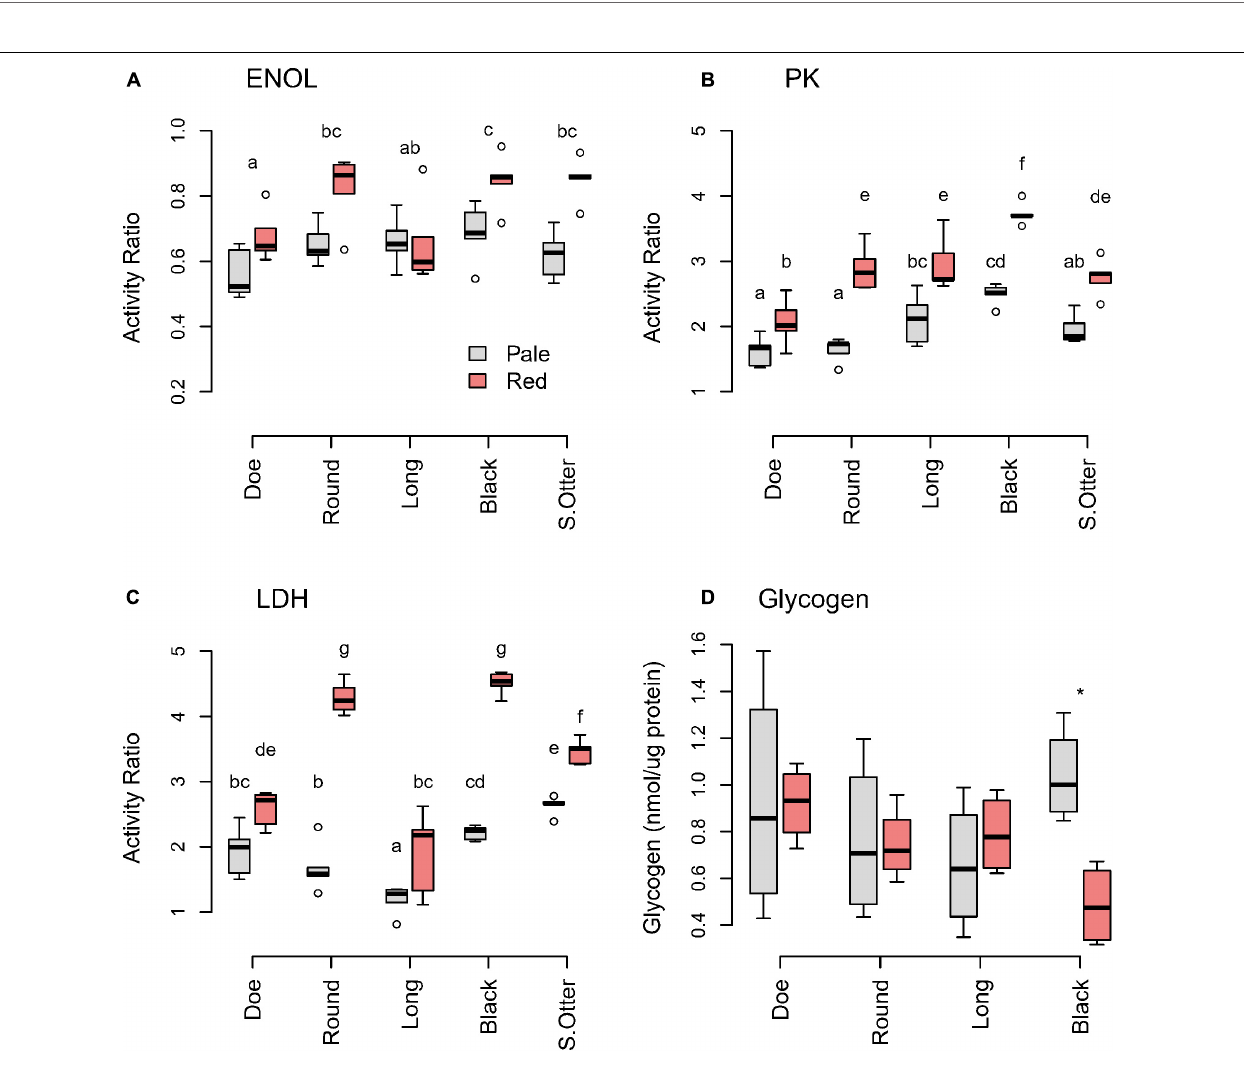
FIGURE 3 | Glycolytic enzyme ( A: ENOL; B: PK; C: LDH) ratios and (D) glycogen of D. pulicaria by color morph across hypoxic lakes. Activities of glycolytic enzymes are expressed relative to the housekeeping gene citrate synthase (CS). Different letters indicate significant differences ( p < 0.05) ( Supplementary Tables 6–10 ). The asterisk (*) indicates significant difference between color morphs in Black